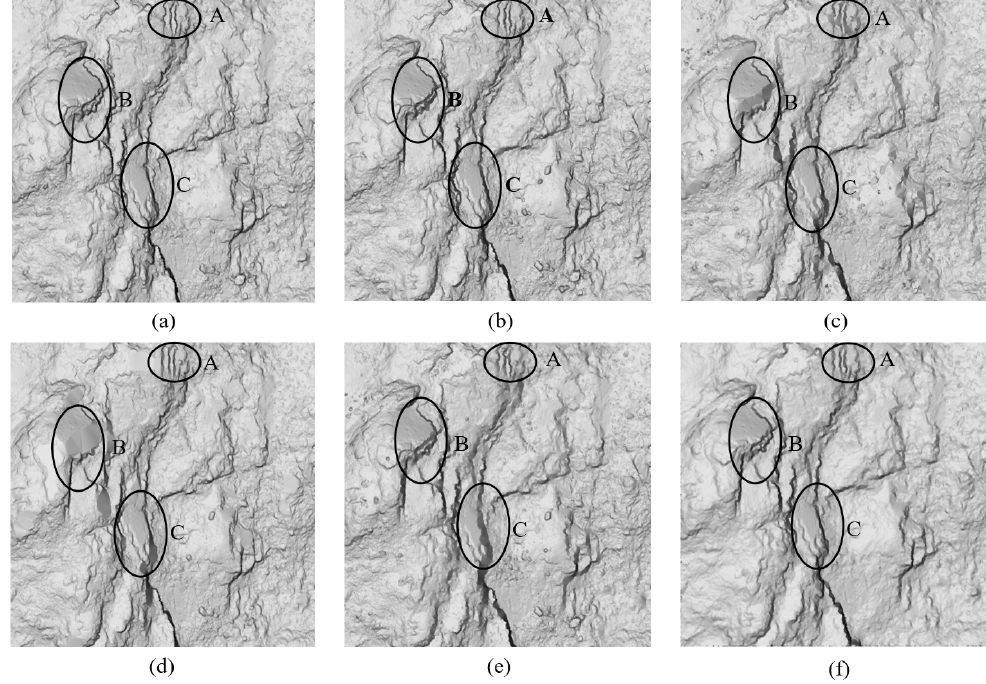
Figure 14. DTMs of ( a ) reference, ( b ) PPDF, ( c ) MSF, ( d ) PMF, ( e ) CSF and ( f ) PTDF in Site 6. MSF, PMF, CSF and PTDF represent the four comparative methods, i.e., maximum slope filtering, progressive morphology filtering, cloth simulation filtering, and progressive triangular irregular network densification filtering methods.